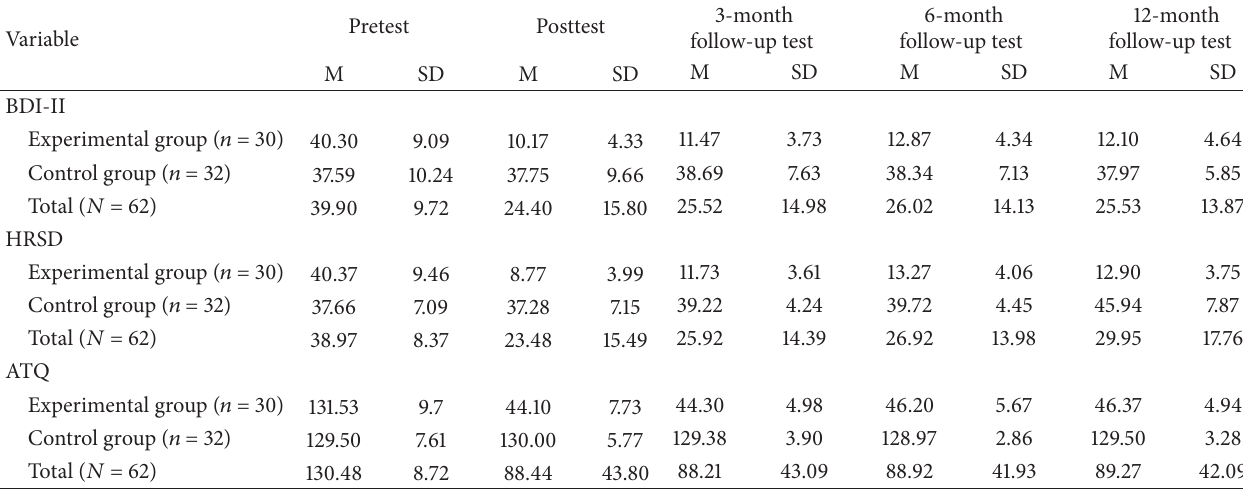
Table 2: Average values on the BDI-II, HRSD, and ATQ.